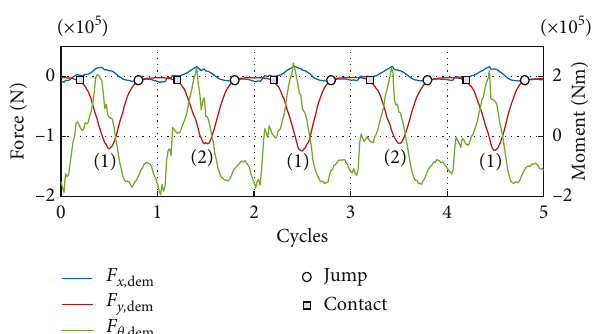
Figure 6: DEM force in x and y directions, and DEM moment in θ direction. Contact and jump points are also